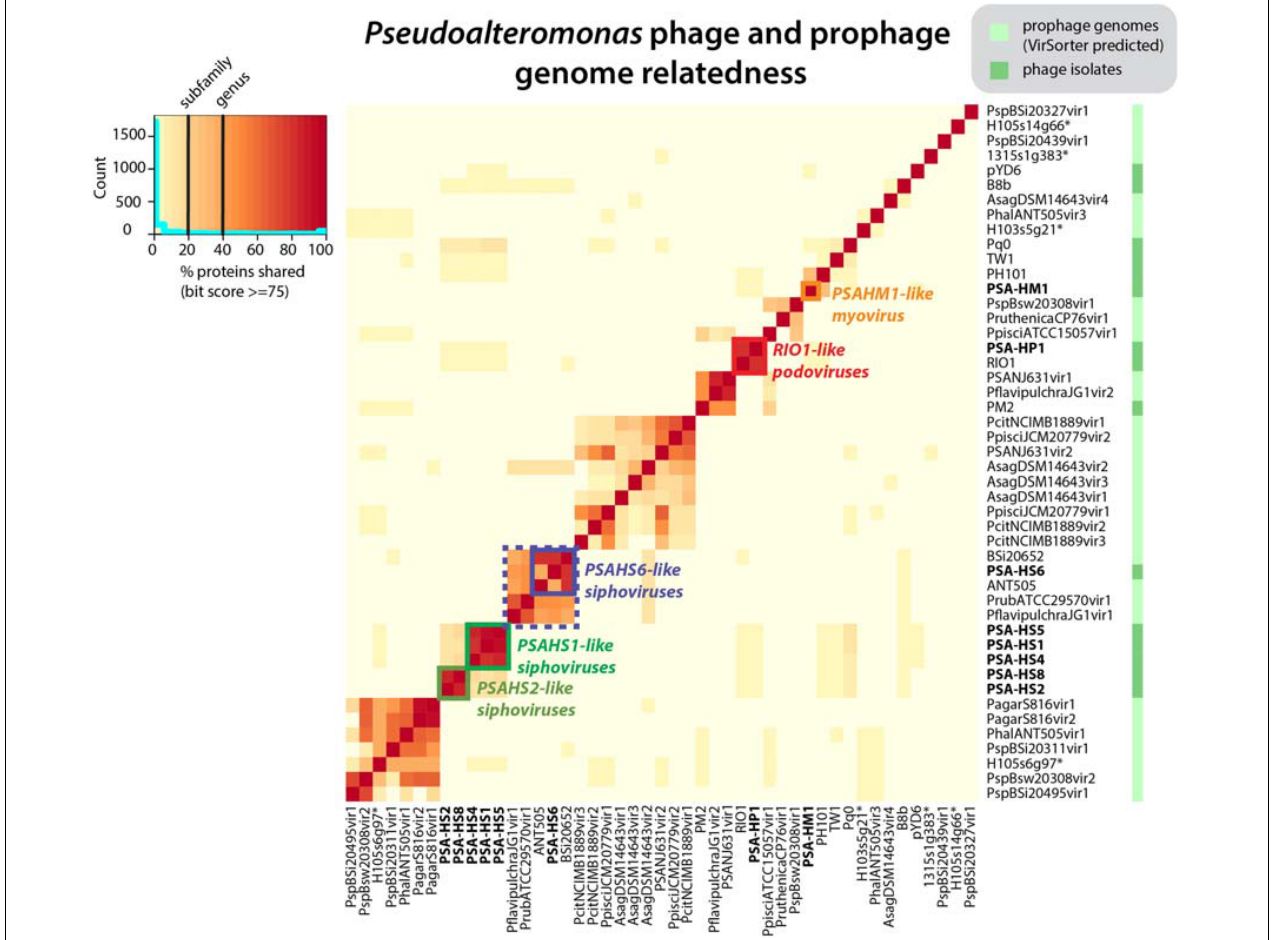
FIGURE 1 | Pseudoalteromonas (PSA) phage genera, as determined by shared protein content between all sequenced PSA phages and prophages identified in silico . Phage isolates and prophages predicted from sequenced Pseudoalteromonas genomes are differentiated on the right hand color strip by dark and light green color blocks, respectively. Legend denotes subfamily ( > 20% proteins shared) and genus (40% proteins shared) delineations, per (Lavigne et al., 2008, 2009). Helgoland PSA phage is indicated by bold text. Candidate new genera comprised of sequenced Helgoland PSA phages are outlined in thick color blocks. ∗ Indicates prophages identified in sequenced Helgoland Pseudoalteromonas spp.